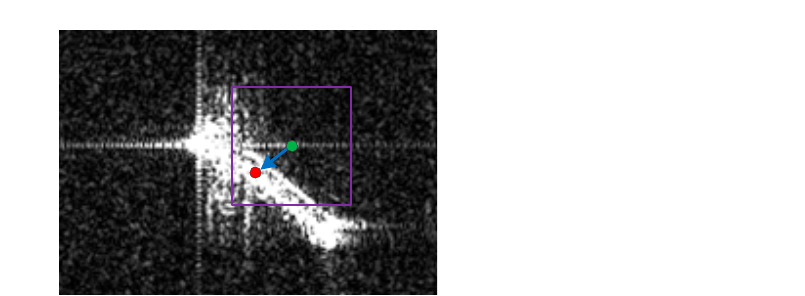
Figure 5. The principal axis extracted through the